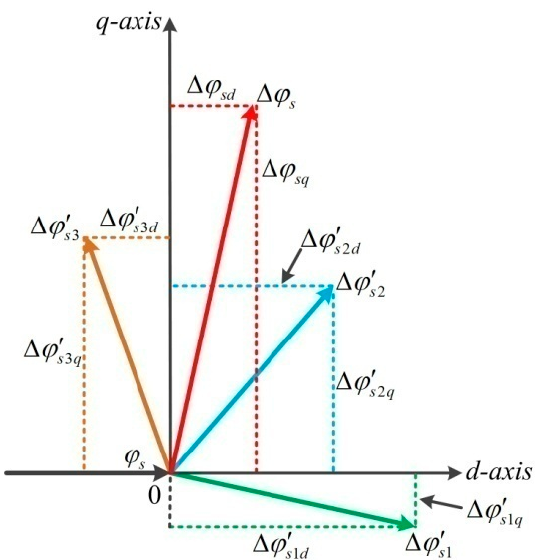
Figure 9. Analysis of error compensational effects provided by different active vectors.